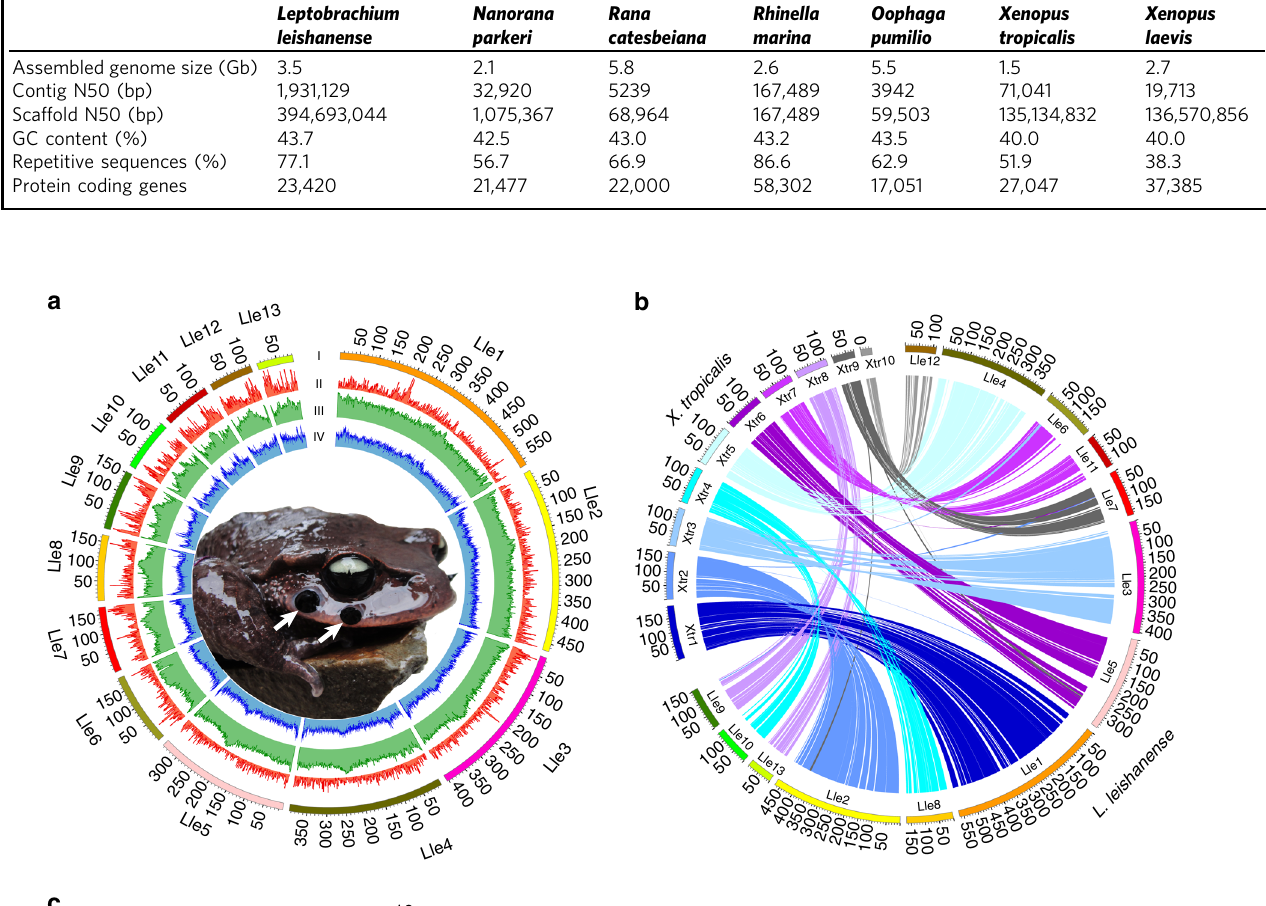
Leptobrachium leishanense